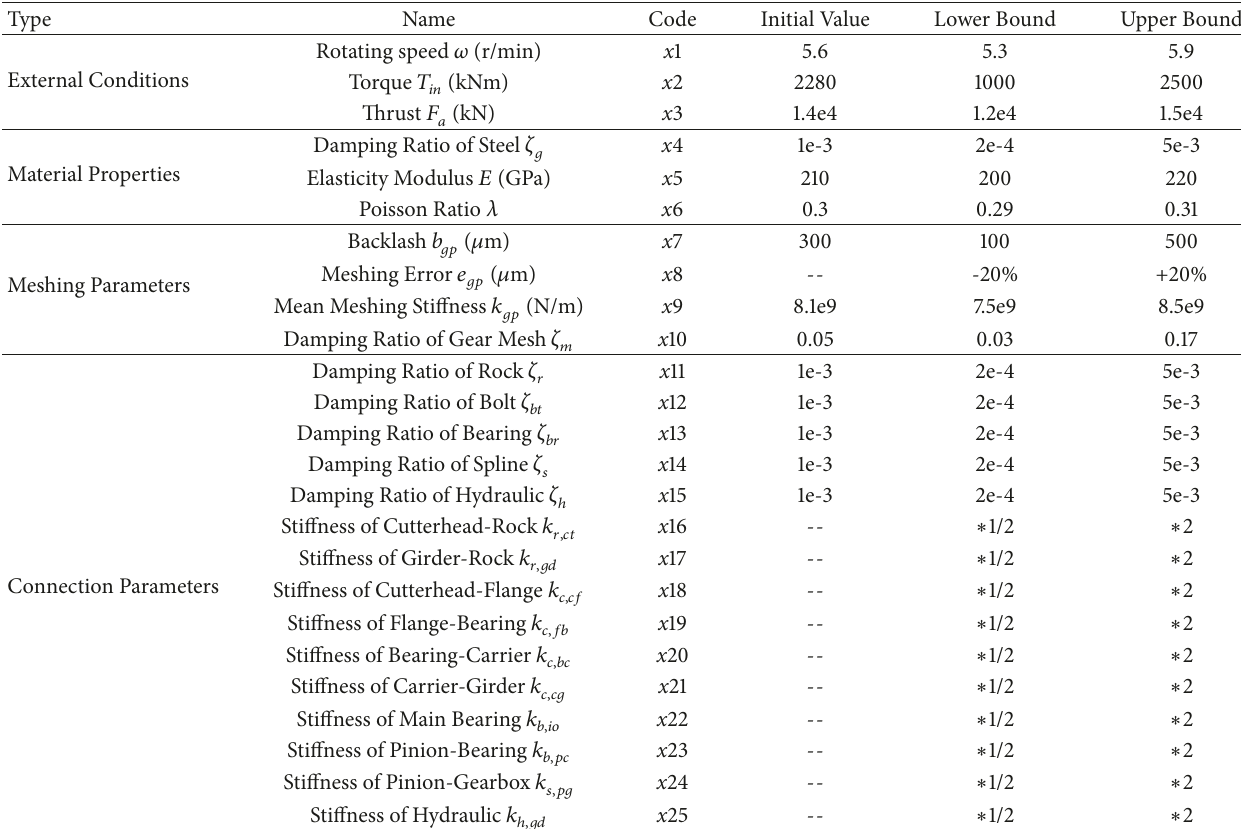
Table 4: Input parameters and their variation ranges.